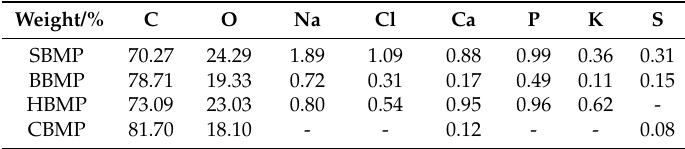
Table 6. Results of elemental analysis.